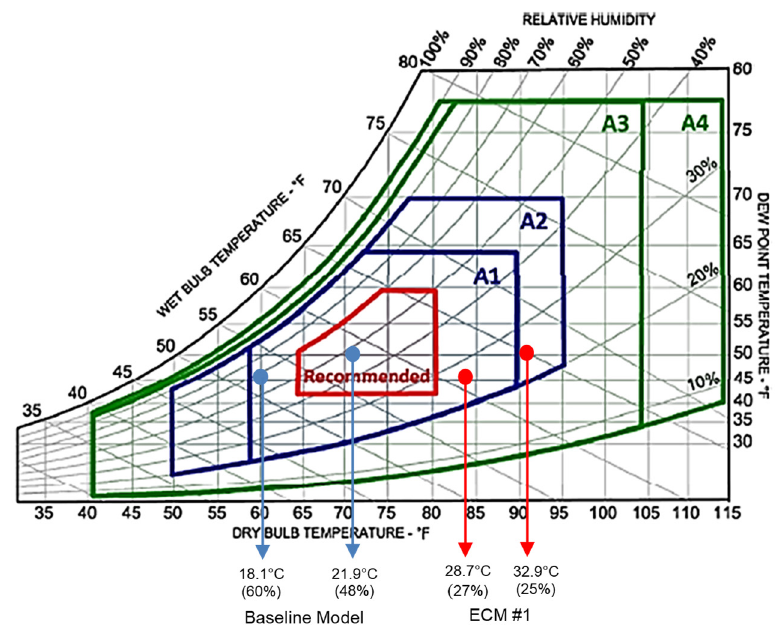
Figure 3. Sever inlet conditions in the ASHRAE guideline [22].